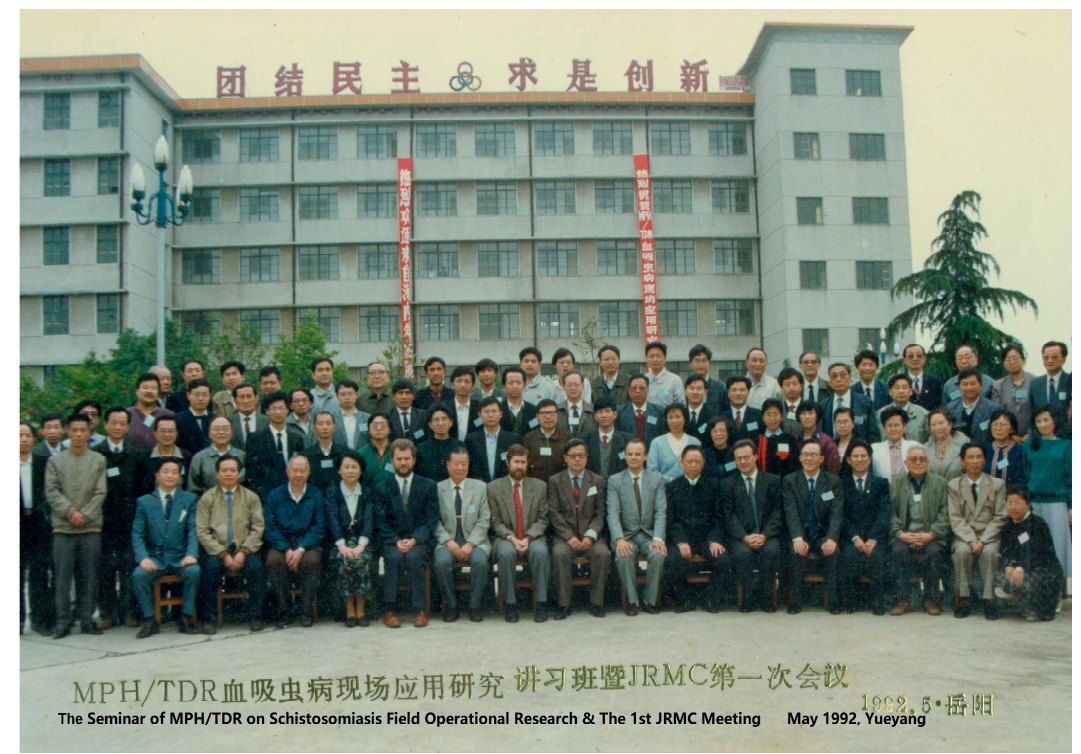
Figure 3. Group photo of initial Joint Research Management Committee (JRMC), held in May 1992 to provide strategic and scientific advice on the 10-year World Bank Loan Project (WBLP) for schistosomiasis control in the People’s Republic of China (Marcel Tanner; first row, 11th from